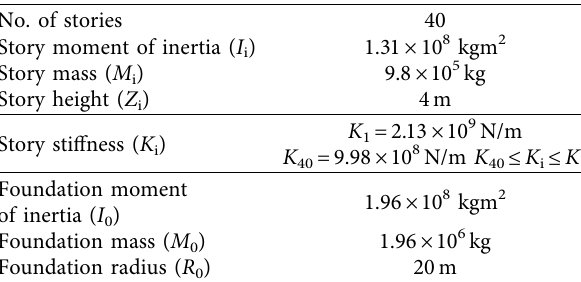
Figure 1: Mathematical model with TMD structure considering soil-structure interaction. Table 1: Structural parameters of the building